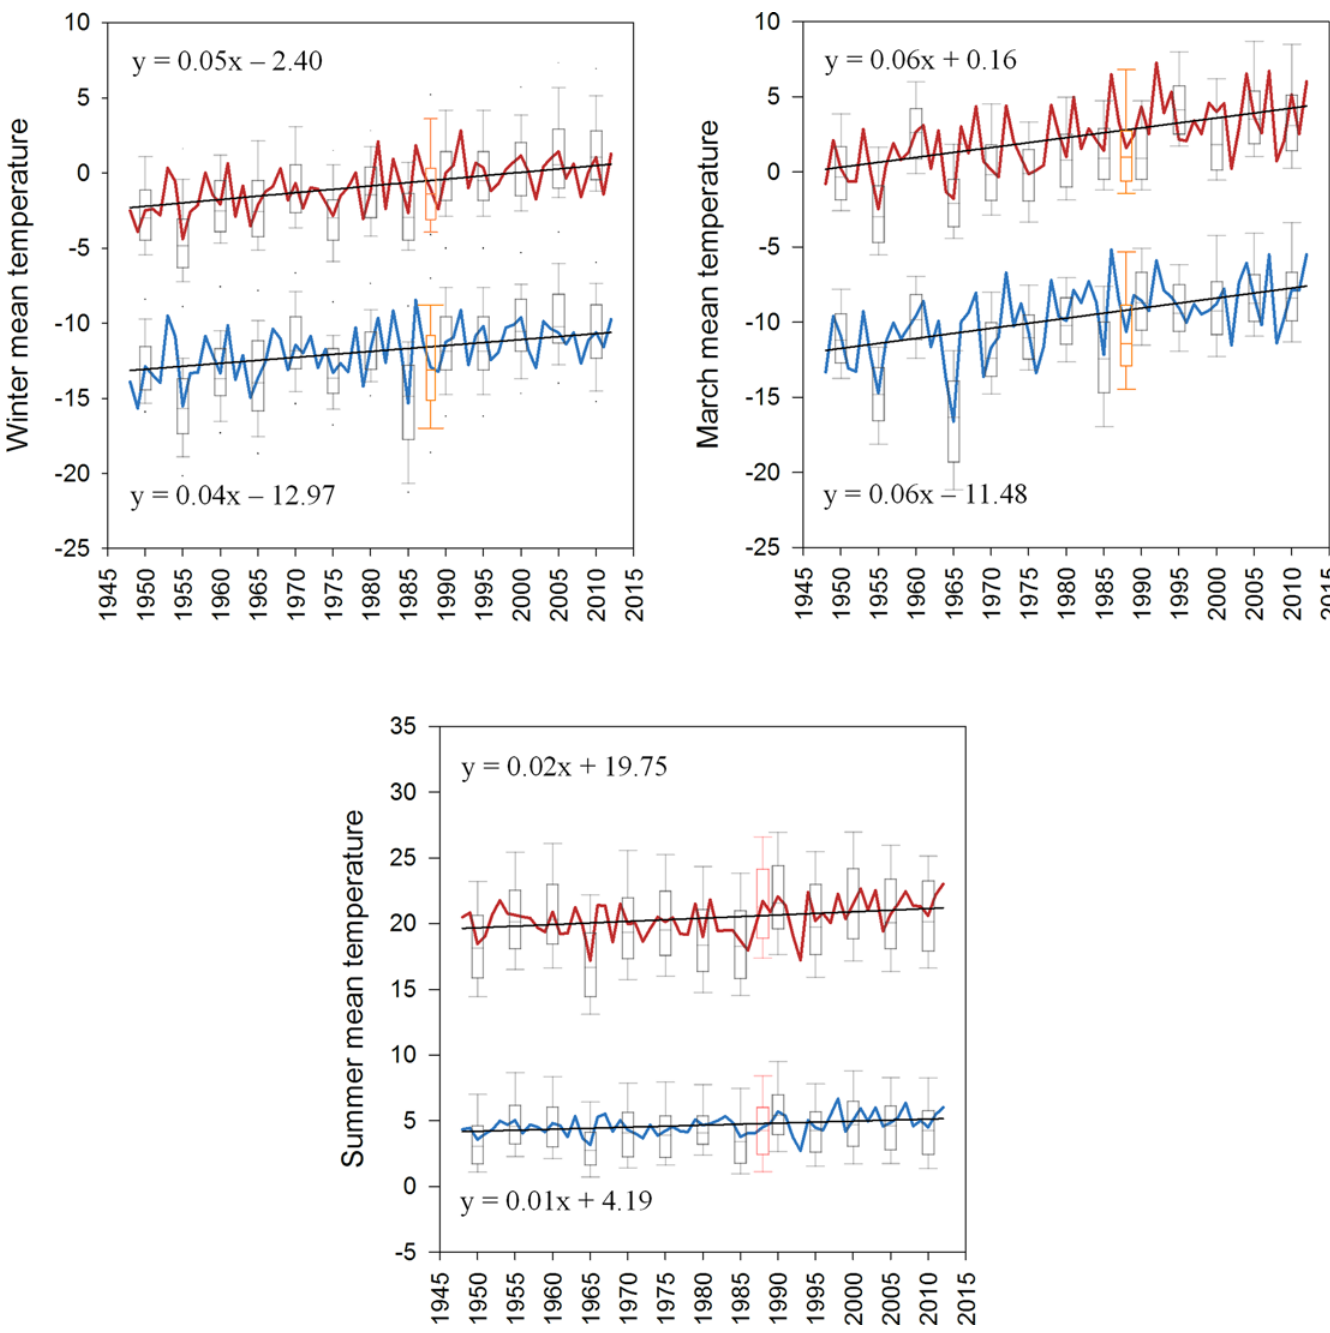
Fig 5. Time series of Winter, March and Summer maximum (red) and minimum (blue) temperatures using the modeled SNOTEL + COOP data, 1948 – 2012. Trend lines and their equations for each time series are shown and are positive and significant ( p < 0 .05; non-parametric Theil-Sen estimator and Mann-Kendall test). Box plots show the median value, box boundaries indicate the 25 th /75 th percentiles and whiskers indicate the 5 th /95 th percentiles of annual temperature values for 50 stations at 5-year intervals and for 1988 (orange), the year of the large Yellowstone